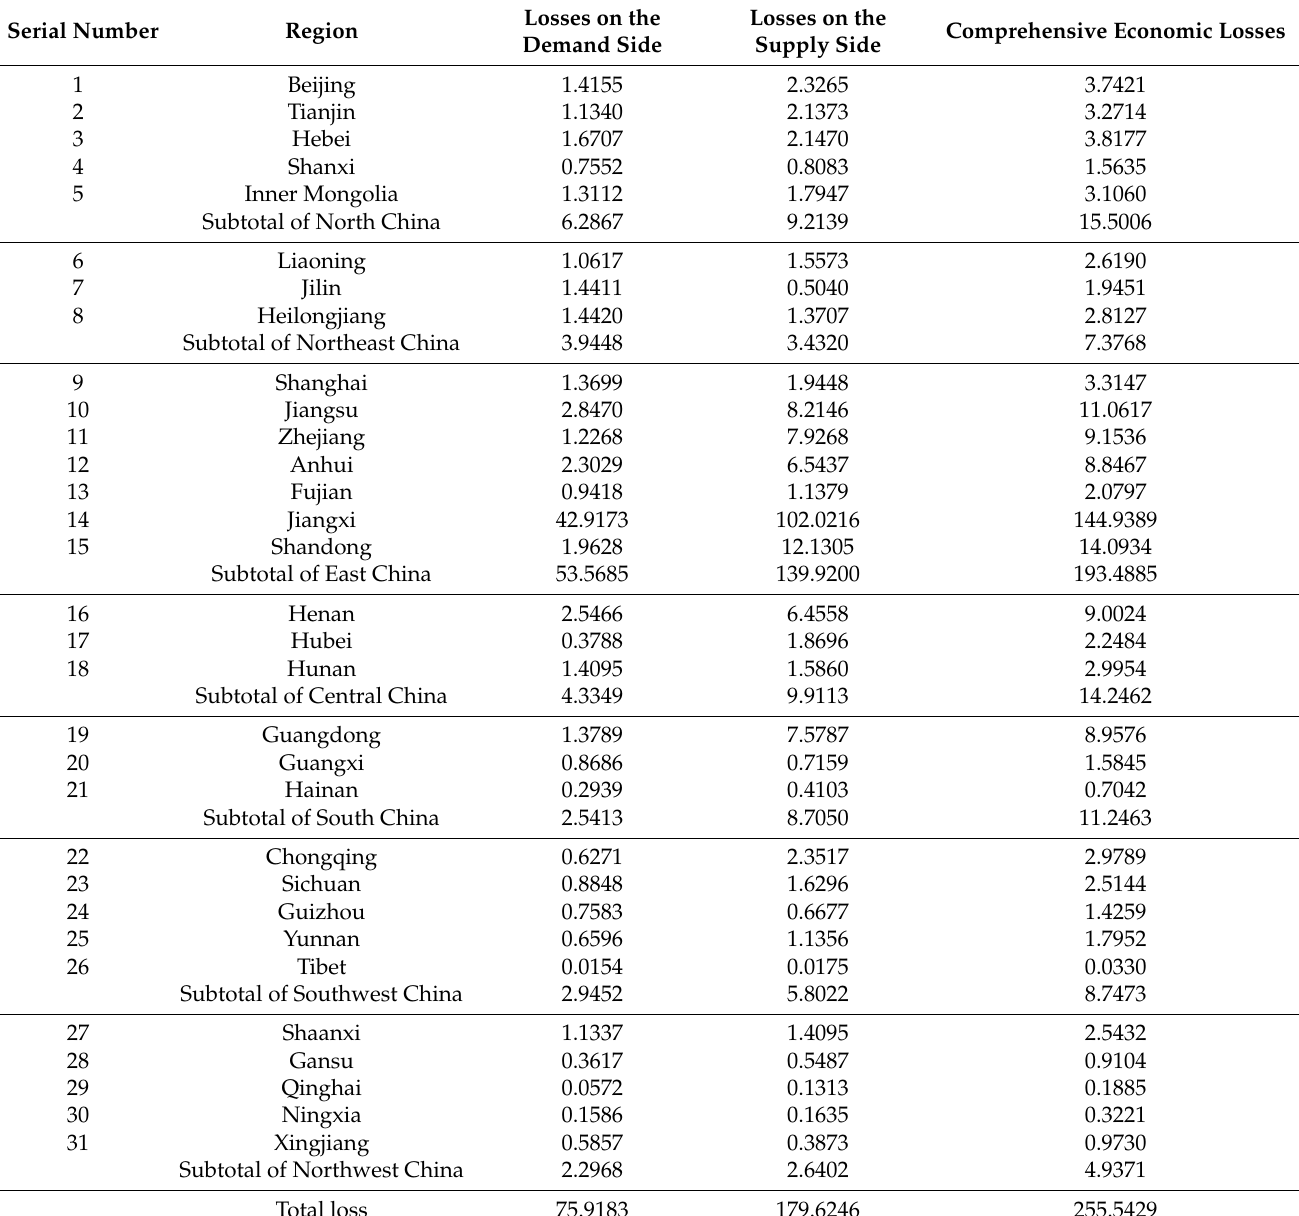
Table 4. Related losses of various regions in China (unit: CNY 100